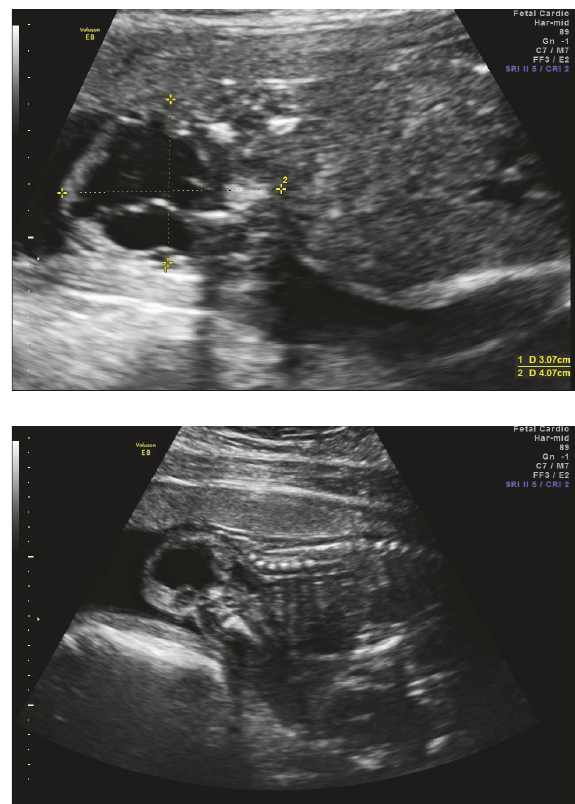
Figure 1: (a) Dimensions of the exophytic mass, measuring 3.07 cm in length and 4.07 cm in width. (b) Exophytic complex mass located in the fetal sacral region with otherwise normal-appearing spine.